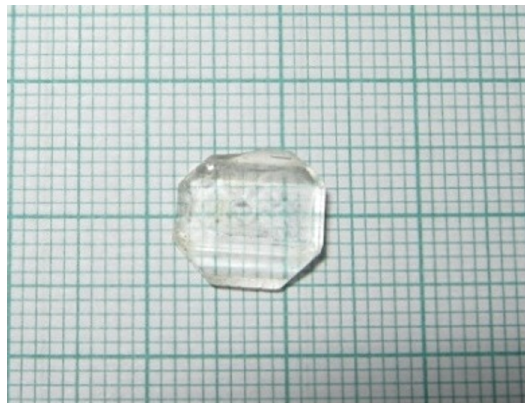
Figure 1. As grown MMTG crystal